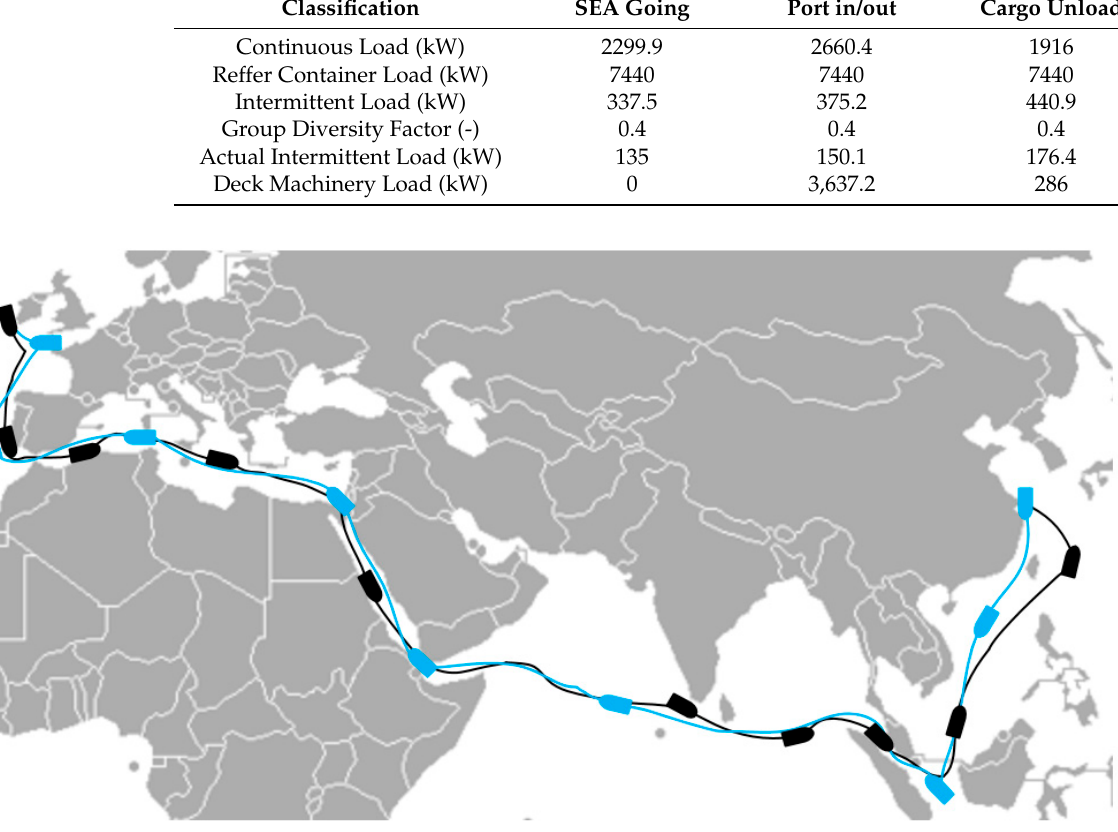
Figure 1. Navigation route.